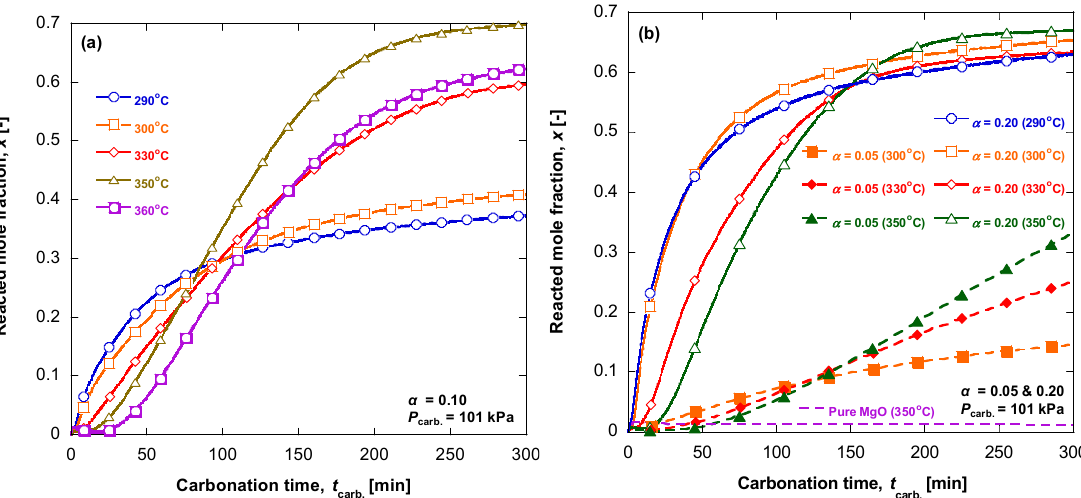
Figure 6. Carbonation kinetics of (LiK)NO 3 / MgO at ( a ) α = 0.10 and ( b ) α = 0.05 and 0.20 at various carbonation temperatures.